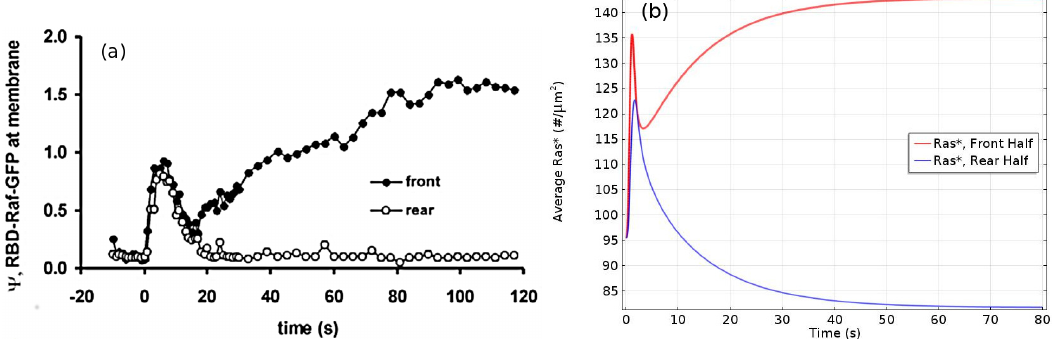
Figure 20. The levels of activated Ras* at the front and back in a static cAMP gradient as a function of time measured experimentally ( a ) From Kortholt et al. [135] and the model prediction ( b ) [133] From Cheng and Othmer